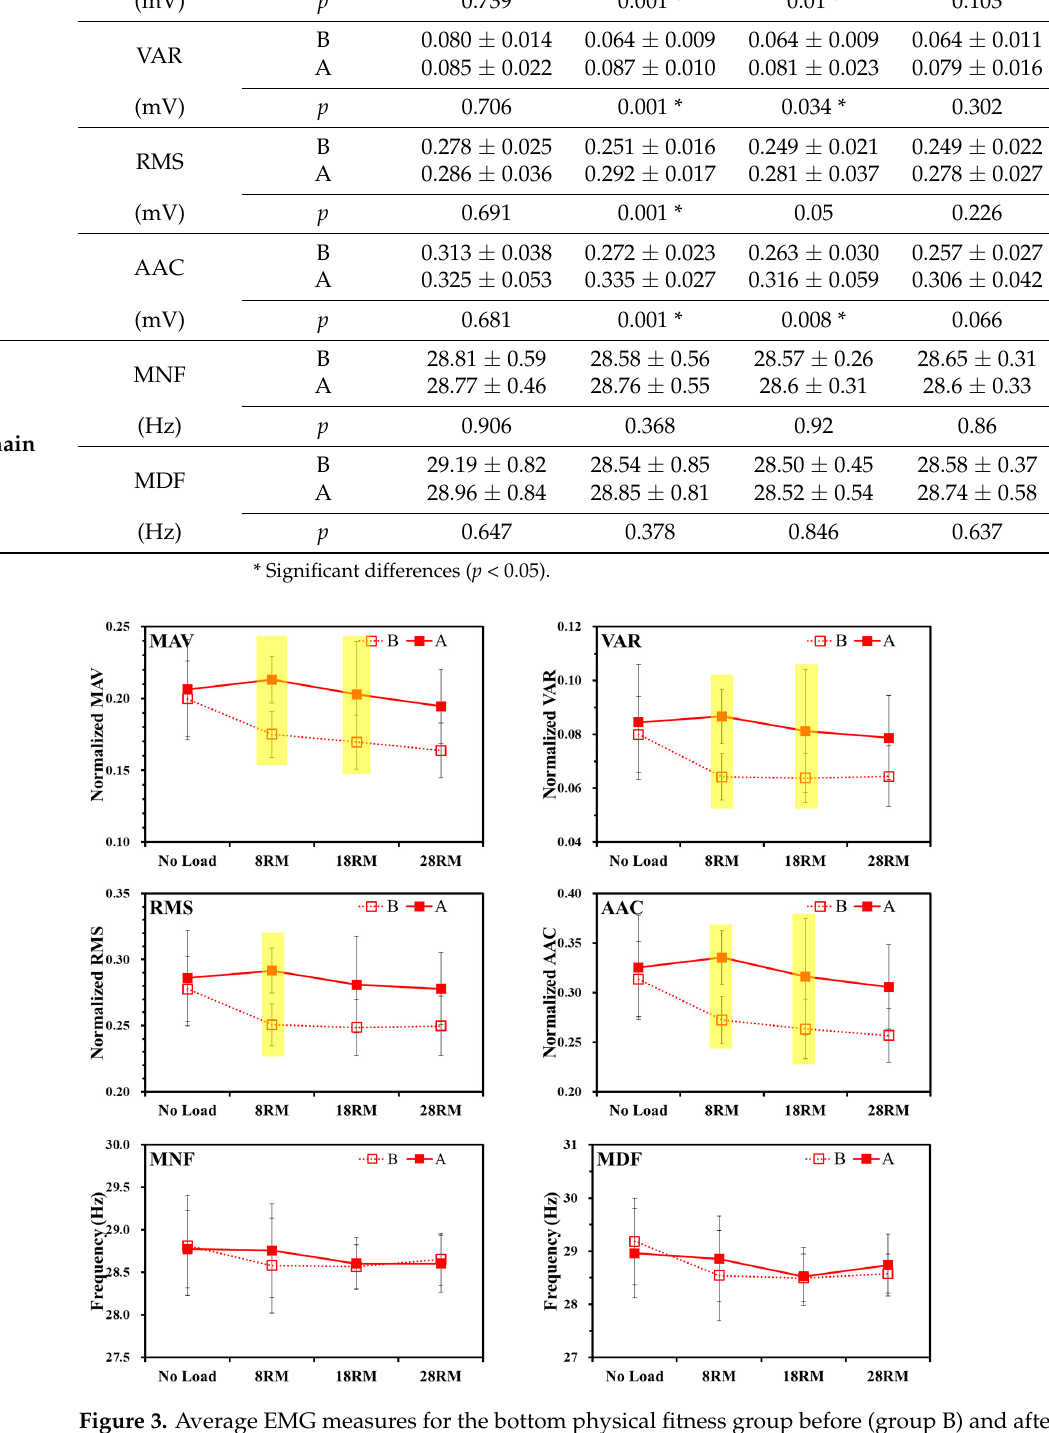
Figure 3. Average EMG measures for the bottom physical fitness group before (group B) and after (group A) the intensive exercise in graded exercise experiments.